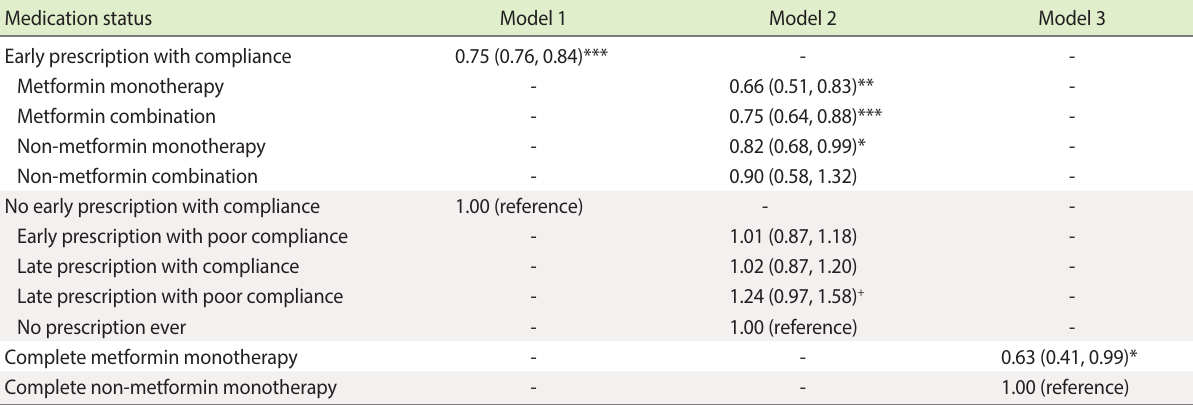
Table 3. Odds ratios 1 of cancer incidence according to prescription medication